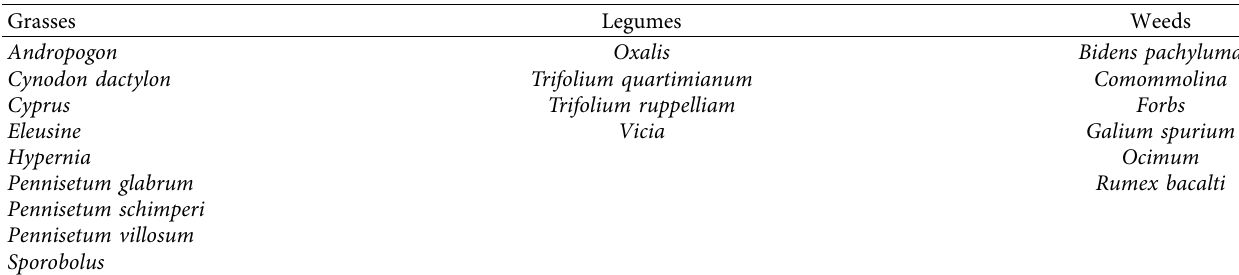
Table 5: Dominant grasses, legumes, and weed species in the natural pasture. Grasses